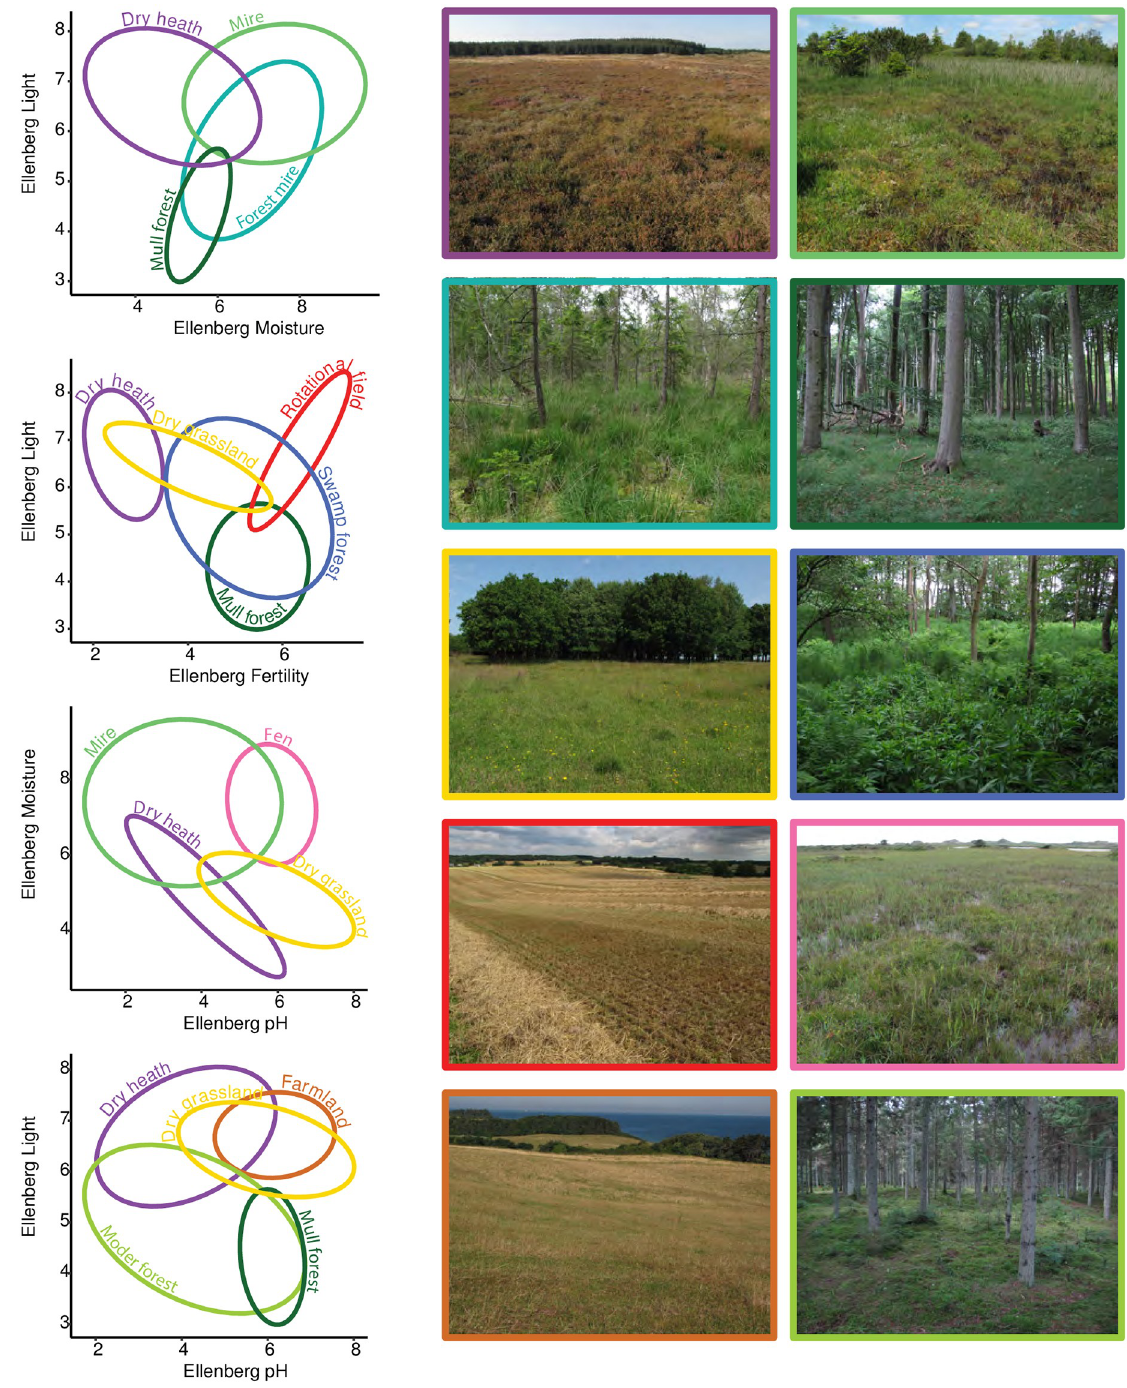
Fig 1. Interpreting Ellenberg Indicator Values. Ellipses showing the multivariate normal distribution of vegetation types plotted along Ellenberg indicator values for light, soil moisture, pH and nutrient status. Agricultural includes rotational fields, old fields and lays. The colors of the ellipses correspond to characteristic sites depicted on the